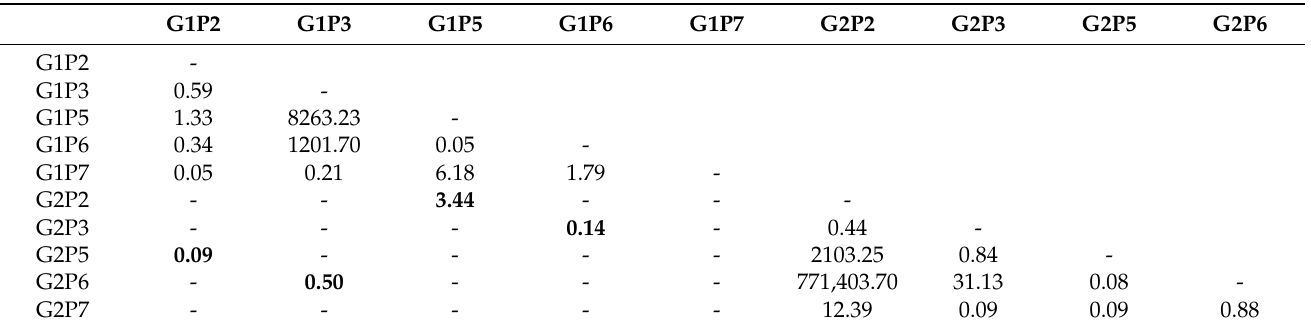
Table 4. Bayes factors for t-test comparisons of the proportion of correct recognition for comparable